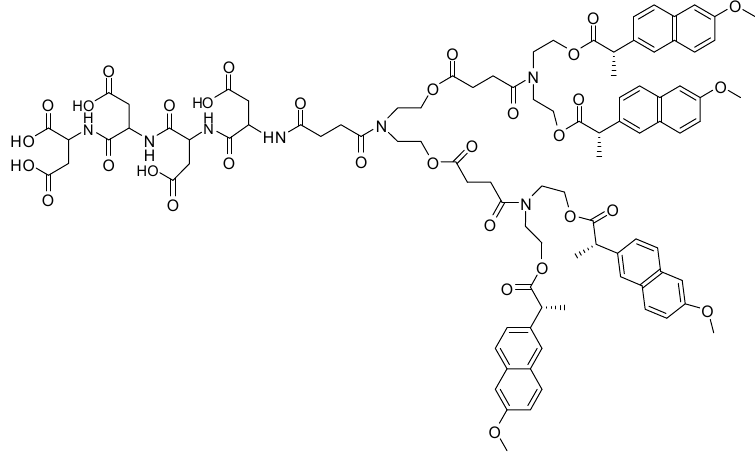
Figure 18. Targeted dendrimer prodrug synthesized by Pan and coworkers [75].